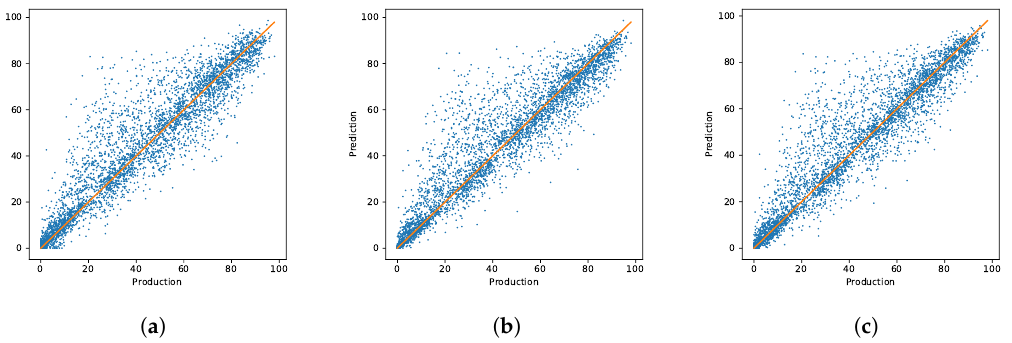
Figure 3. Real energy production against prediction made by the best CTL ( a ), ITL ( b ), and MTL ( c ) models in tenerife in terms of MAE; the perfect prediction line is shown in orange. The units of the axis are